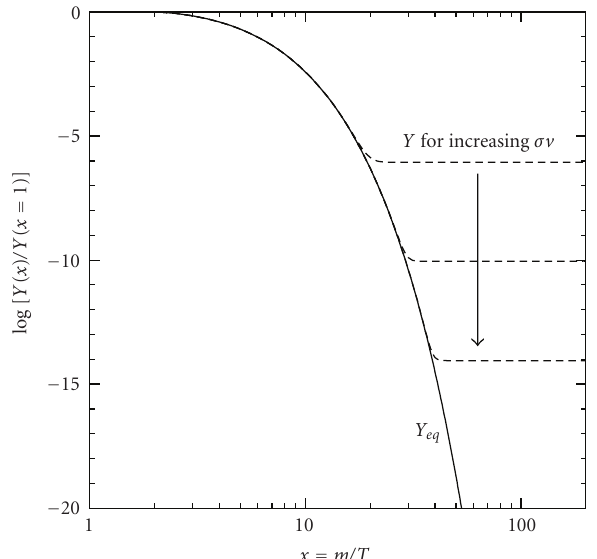
Figure 5: The evolution of Y ( x ) /Y ( x = 1) versus x = m/T where Y = n/s